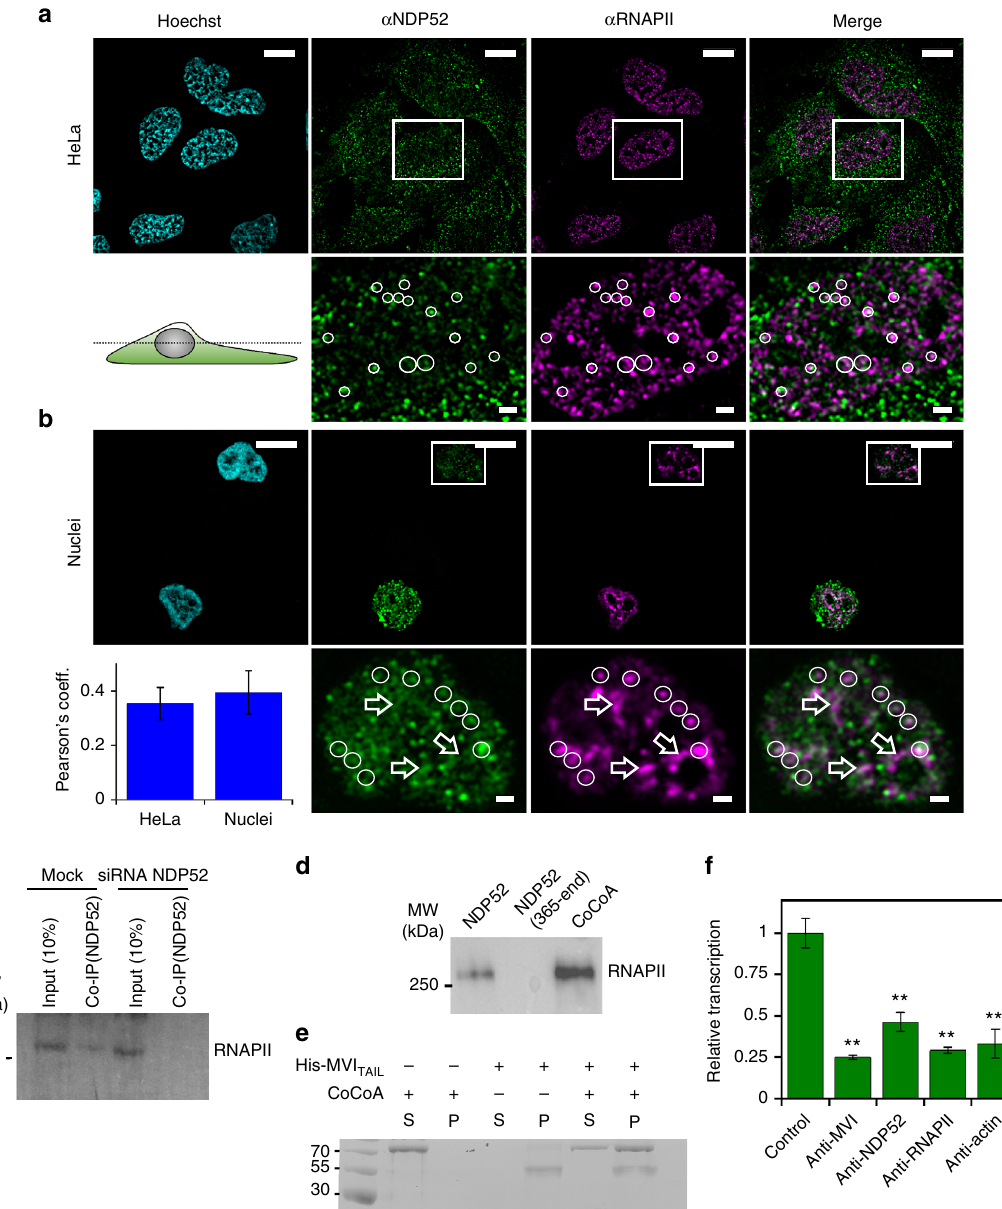
Fig. 6 NDP52 transcription regulation. a Immuno fl uorescence staining against NDP52 (green), RNAPII (magenta) and DNA (cyan), as performed in Fig. 1b. Insert depicts colocalising foci. Scale bar 10 μ m for whole images and 1 μ m for inserts. b Immuno fl uorescence on HeLa nuclei as in (a) with Pearson ’ s coef fi cient (error bars represent SEM from 10 images). c Co-immunoprecipitation of NDP52 and RNAPII, using an antibody against NDP52 to immunoprecipitate RNAPII from HeLa cells. Immunoprecipitation does not occur in HeLa cells subjected to siRNA knockdown of NDP52. d Western blot against RNAPII following isolation from nuclear extracts by NDP52 constructs and CoCoA. Loading controls for the recombinant proteins is shown in Supplementary Fig. 9. e Pull-down of CoCoA by His-tagged N MVI TAIL both at 5 μ M. P and S represent pellet and supernatant fractions. f In vitro transcription by HelaScribe extracts following antibody depletion as described in Methods. Samples were normalised to a non-depleted control reaction (error bars represent SEM ** p < 0.001 by two-tailed t -test) from 5 independent experiments (Supplementary Fig. 8a,